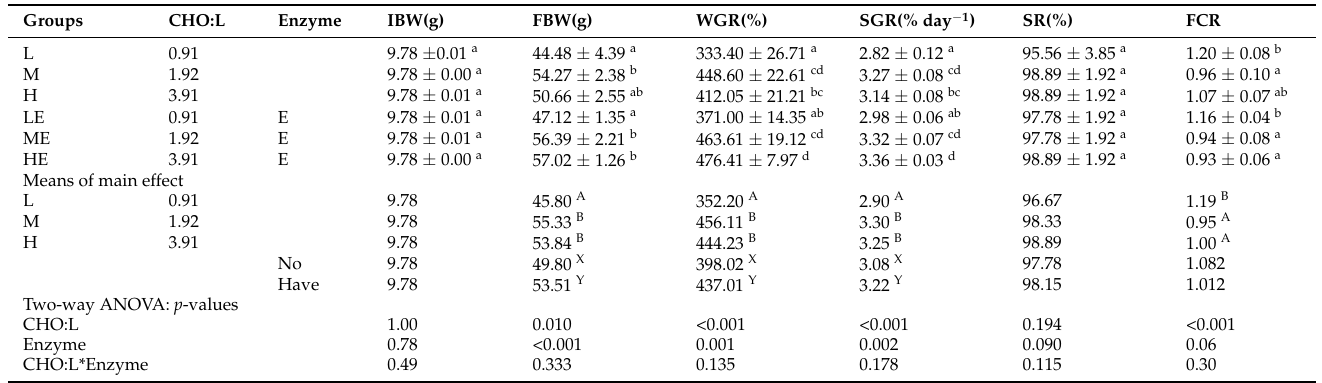
Table 3. Effects of carbohydrase supplementation on growth performance, survival and feed utiliza- tion in hybrid grouper fed different CHO:L ratios diets (n =